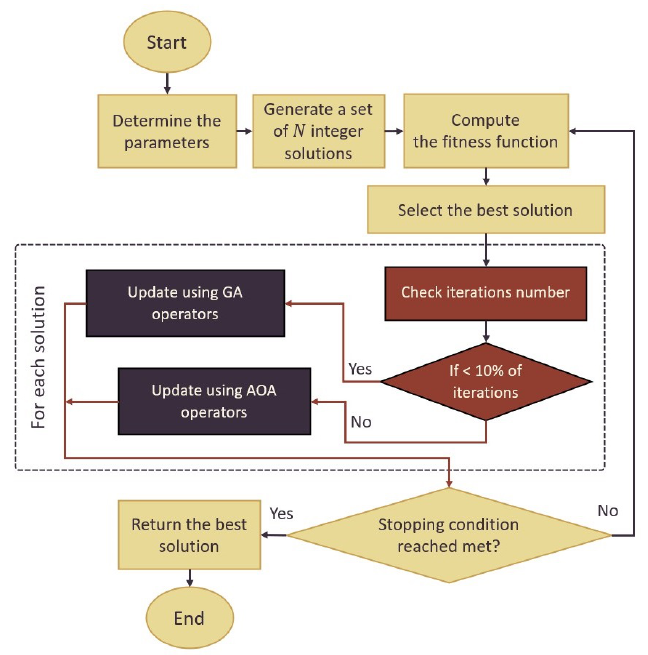
Figure 2. Flowchart of the proposed